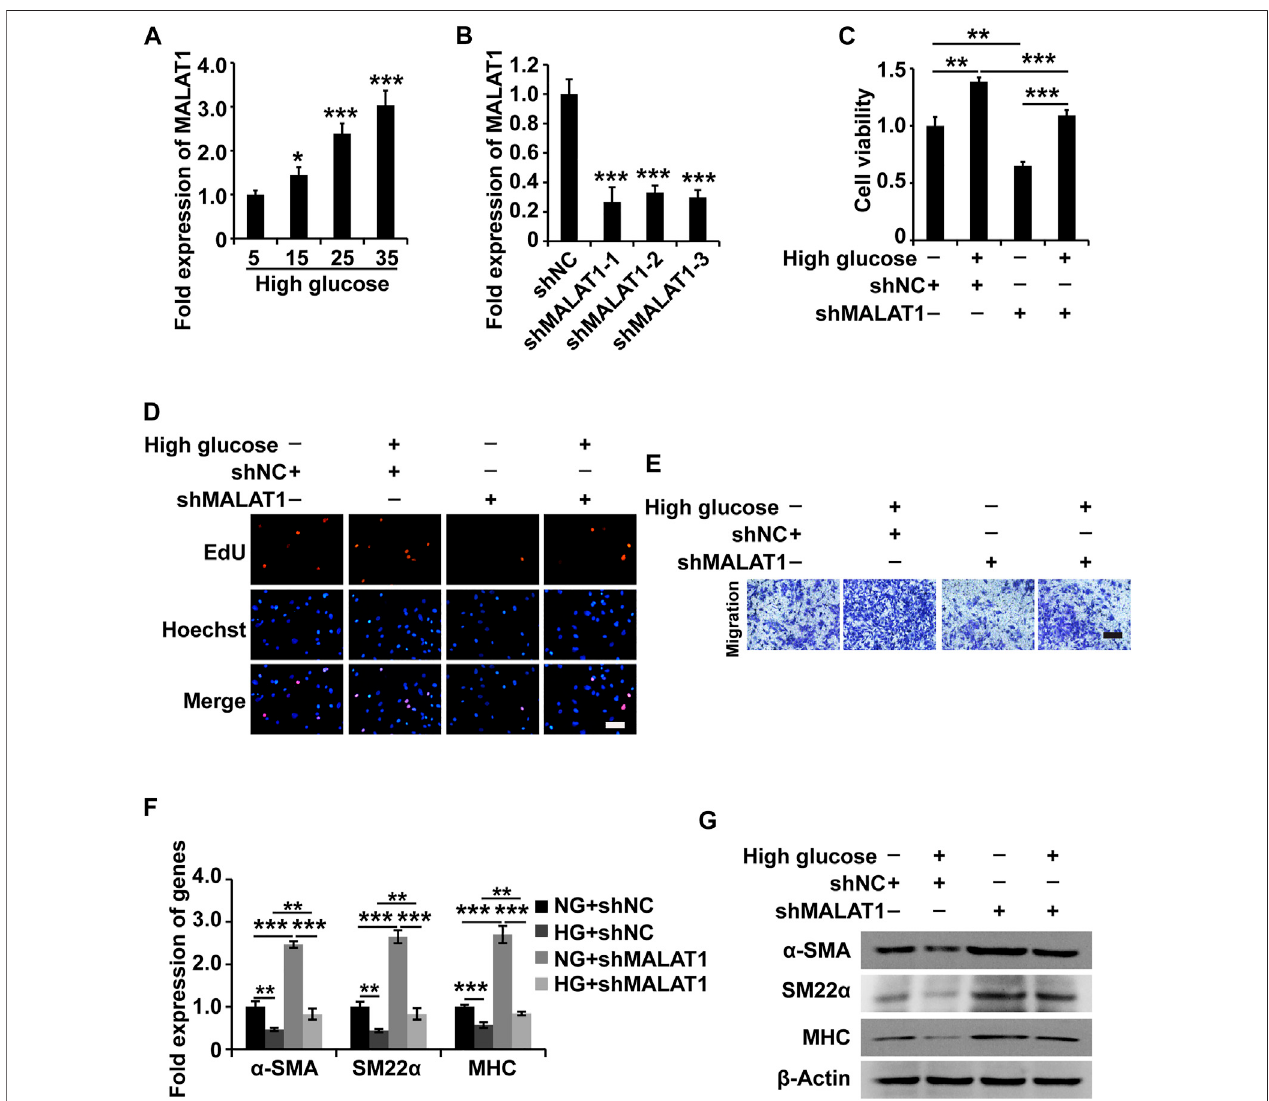
FIGURE 2 | MALAT1 knockdown attenuates the HG-induced promotion of cell viability, proliferation, migration, and phenotypic switching in HGSMCs. (A) qPCR analysisoftheexpressionofMALAT1inHGSMCstreatedwithdifferentconcentrationsofglucose(5,15,25,and35 mM)for48 h. (B) qPCRanalysisoftheexpressionof MALAT1 in HGSMCs 48 h after transfection with shMALAT1s and shNC. (C – E) The CCK8, EdU, and Transwell assays were carried out to analyze the viability, proliferation,andmigrationofHGSMCsunderdifferenttreatments. (F – G) qPCRandwesternblotanalysesofSMCcontractilemarkers( α -SMA,SM22 α ,andMHC) in HGSMCs under differenttreatments.For (C – G) ,four groupsofcellswereused:NG+shNC group,HG+shNC group,NG+shMALAT1group, and HG+shMALAT1 group. β -Actin was used as an internal control. *** p < 0.001, ** p < 0.01, * p < 0.05.